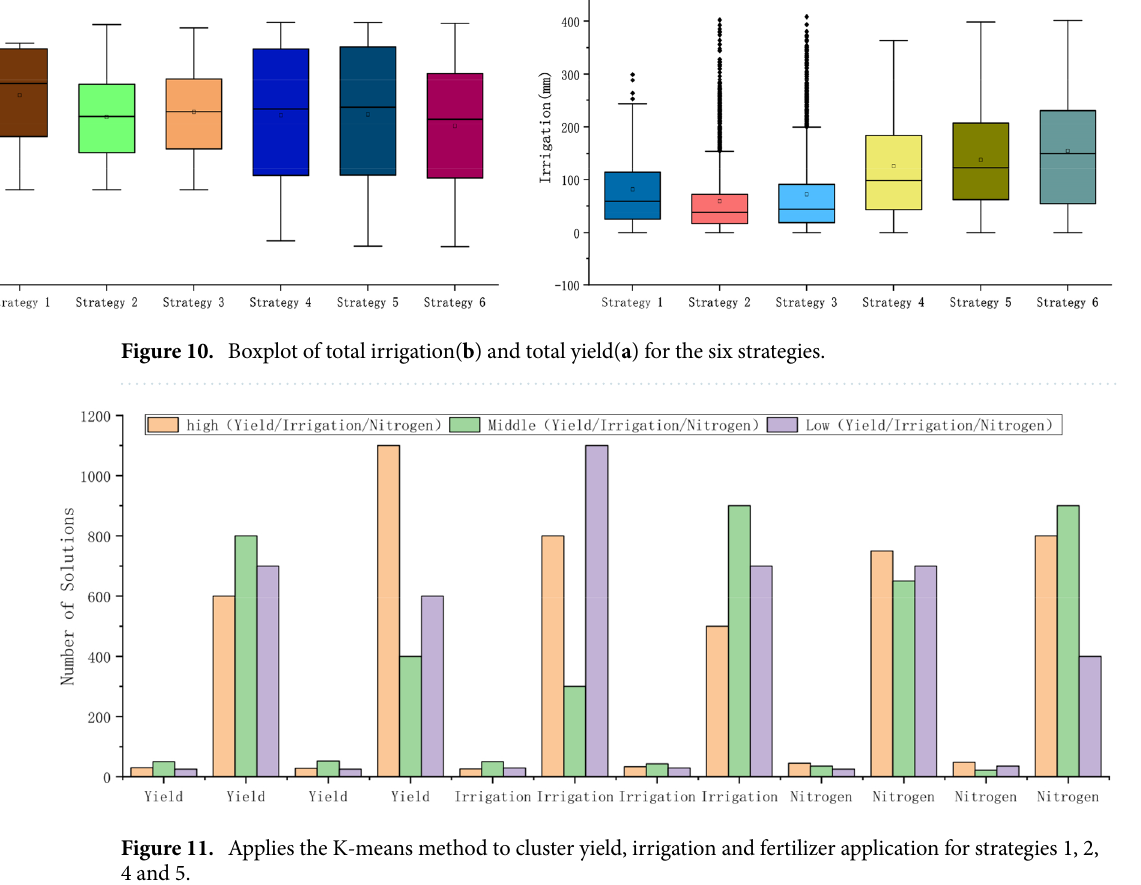
Figure 11. Applies the K-means method to cluster yield, irrigation and fertilizer application for strategies 1, 2, 4 and 5.